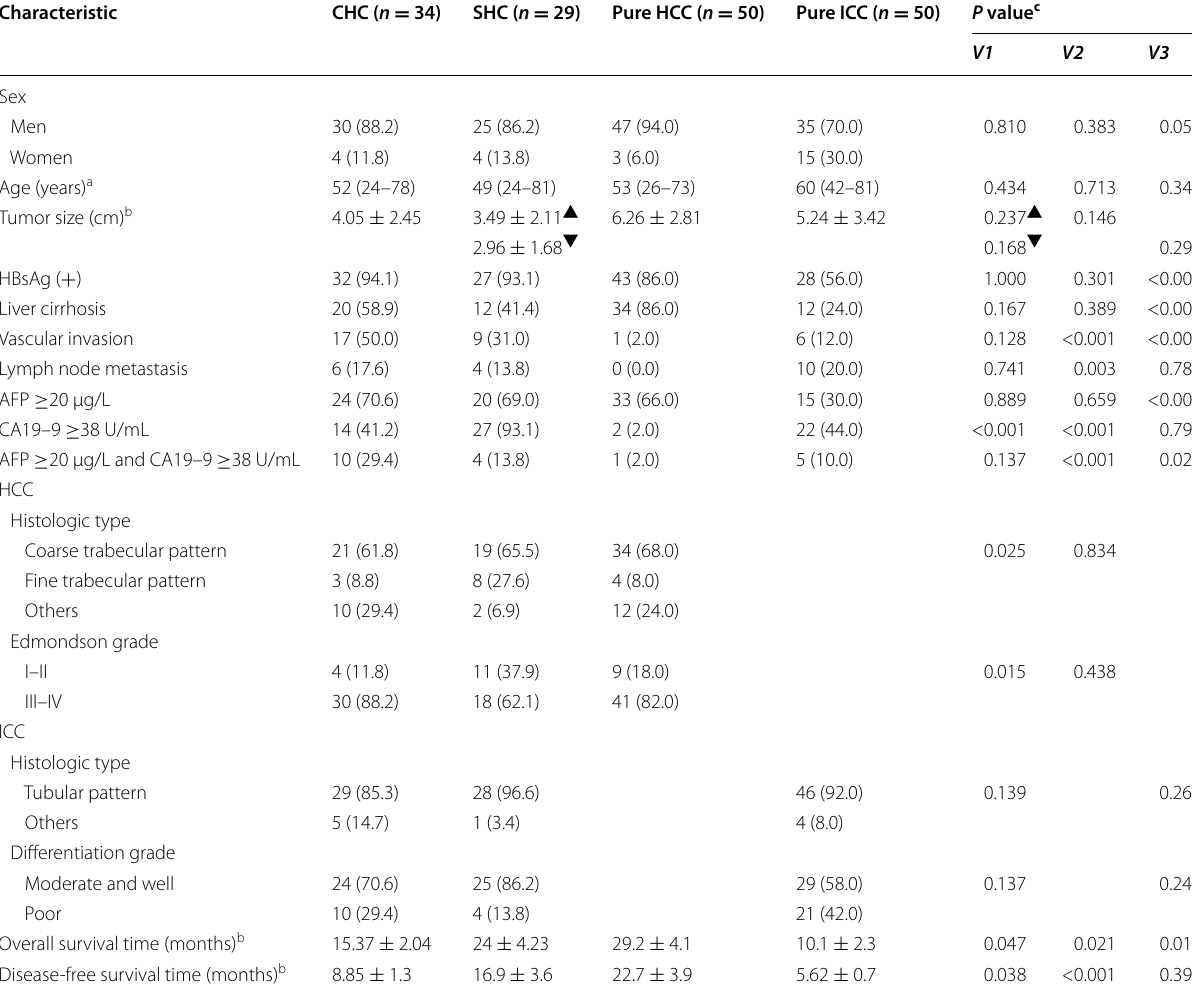
Table 2 Comparison of clinicopathologic features among patients with CHC, SHC, pure HCC, and pure